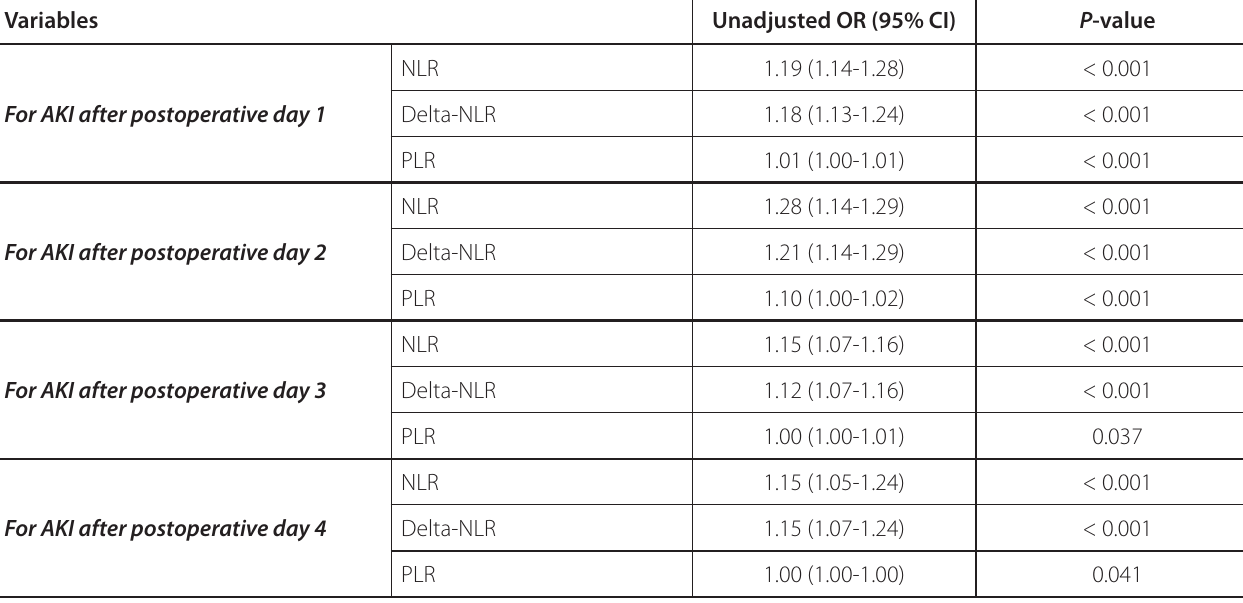
Table 5 . Univariate regression analyses of the hematological indices for the prediction of AKI for each postoperative day. Variables Unadjusted OR (95% CI)